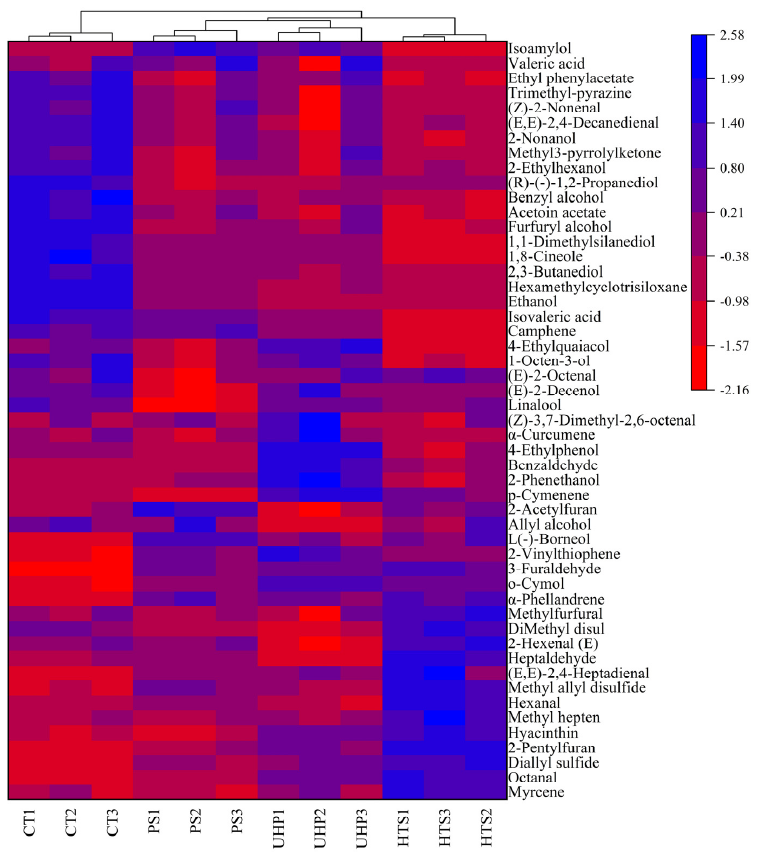
Figure 5. Heatmap analysis of the contents of some volatile compounds in four samples.